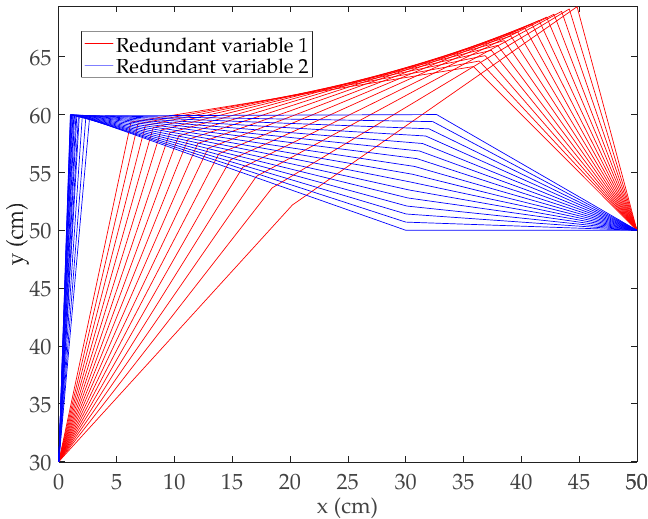
Figure 13. Redundant space with different free motion ranges at point D 2 ( 50,50 )